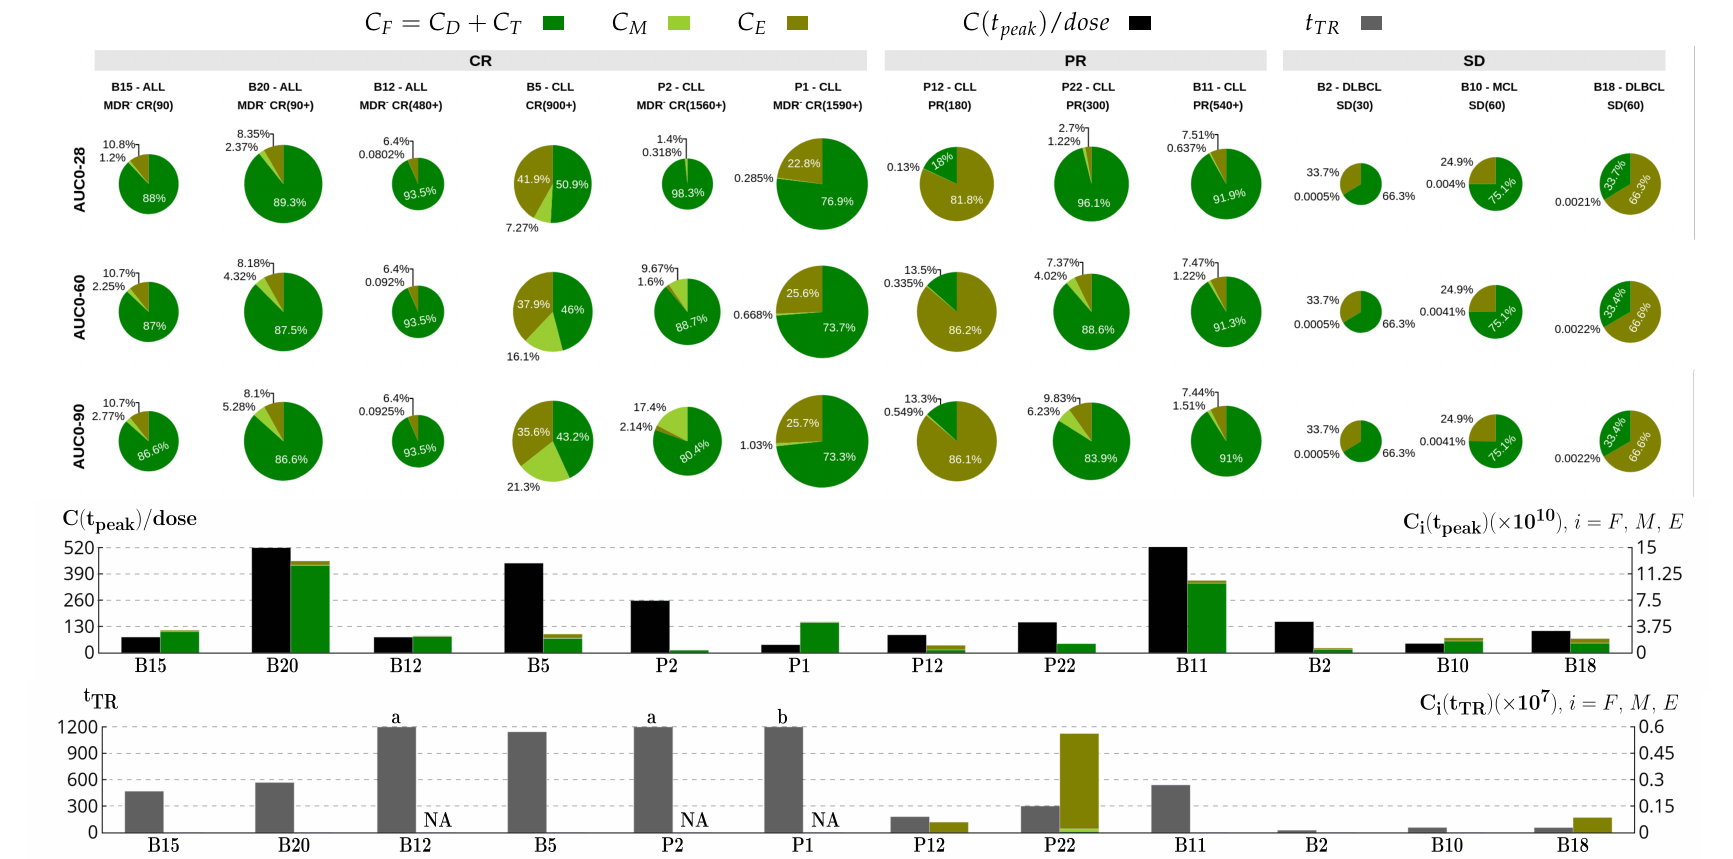
Figure 5. CAR-T therapy outcomes for different patients (one in each column) with ALL, CLL, MCL, or DLBCL with different therapy responses (CR—complete response, PR—partial response, and SD—stable disease). Pie charts display the fractions of functional, memory, and exhausted cells composing the area under the curve of the entire CAR-T population during the first 28 (first row), 60 (second row), and 90 (third row) days after infusion; absolute values of AUC are indicated by the radii of the pies. The bar plot in the fourth row shows the ratio between the CAR-T cell peak value and the infused dose (in black), along with the quantity of each CAR-T cell subpopulation (green tones) on the day when the subpopulation is at the peak time. The bar plot at the bottom presents the time of the theoretical relapse ( t TR , gray) and the corresponding CAR-T cell subpopulations (green tones). NA (not applicable) indicates no theoretical relapse due to: (a) the occurrence of the limit cycle at undetectable levels; (b) no tumor recurrence within 20,000